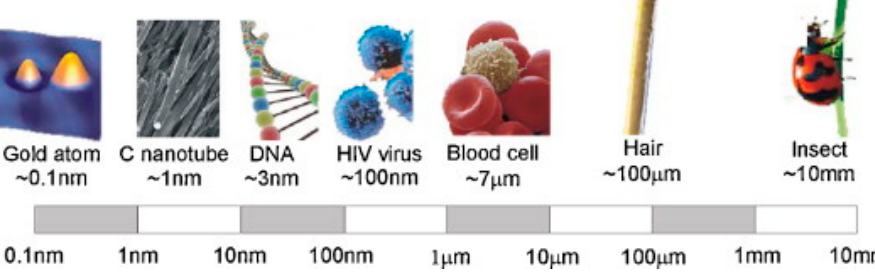
Figure 1. The representation of nanomaterials’ length measured in nanosize [1].